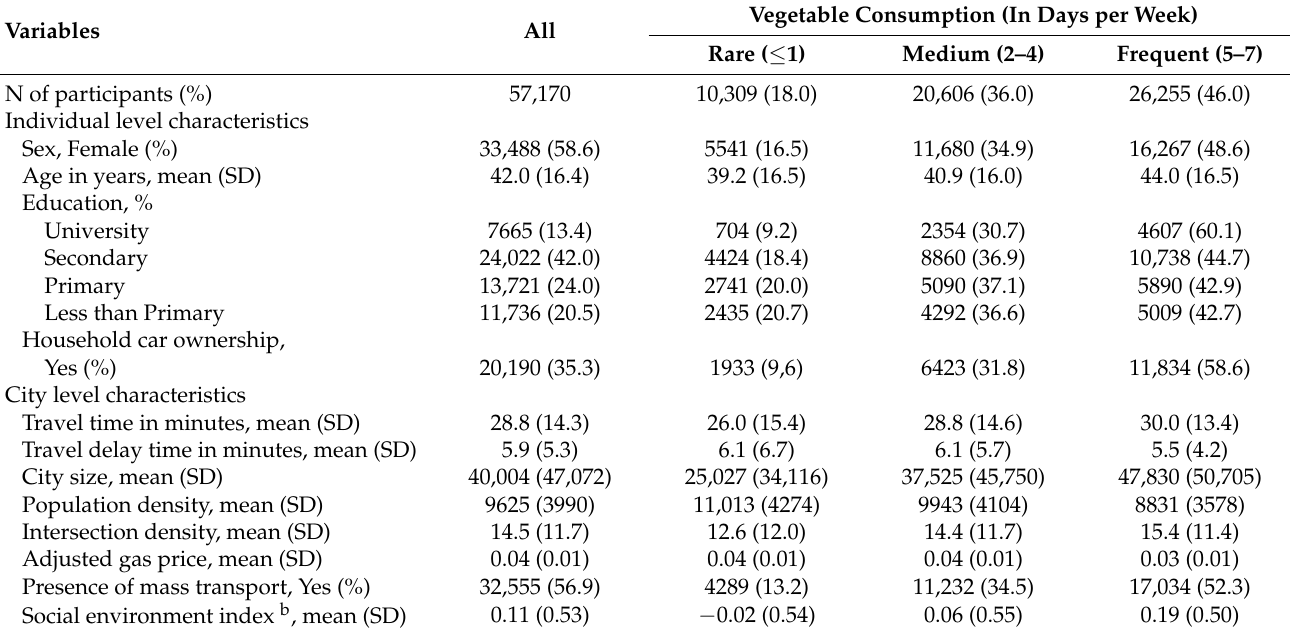
Table 1. Characteristics of the sample a , overall and by vegetable consumption